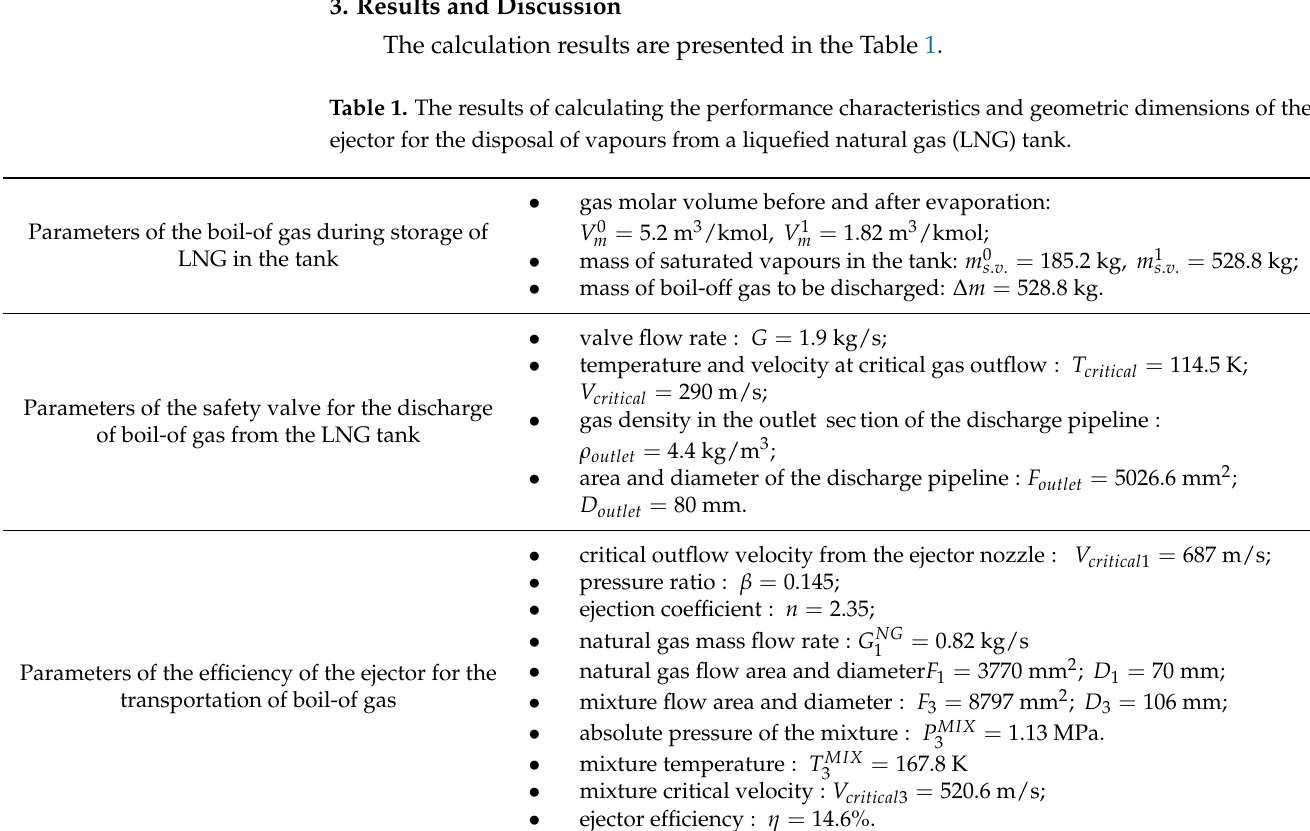
Table 1. The results of calculating the performance characteristics and geometric dimensions of the ejector for the disposal of vapours from a liquefied natural gas (LNG) tank.